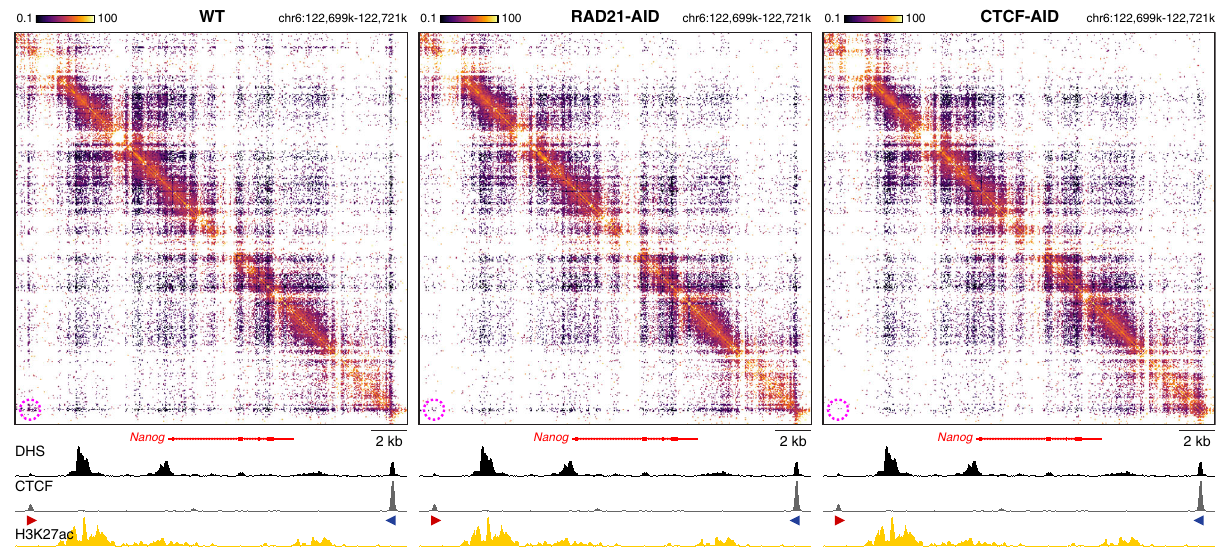
Fig. 6 Micro-topologies of the Nanog locus upon cohesin and CTCF depletion. The contact matrices show ligation junctions identi fi ed by Tiled-MCC in a 22 kb region containing the Nanog locus at 50 bp resolution in wild-type (WT), auxin-treated RAD21-AID, and auxin-treated CTCF-AID mES cells. Gene annotation, DNase hypersensitive sites (DHS), and ChIP-seq data for CTCF and H3K27ac are shown below the matrices. The axes of the DHS and ChIP- seq pro fi les for CTCF and H3K27ac are fi xed and have the following ranges: DHS = 0 – 5; CTCF = 0 – 1500; H3K27ac = 0 – 50. The orientations of CTCF motifs at prominent CTCF-binding sites are indicated by arrowheads (forward orientation in red; reverse orientation in blue). The magenta highlights in the contact matrices indicate enriched interactions between CTCF-binding elements in WT mES cells, which are decreased in auxin-treated RAD21-AID and auxin-treated CTCF-AID mES